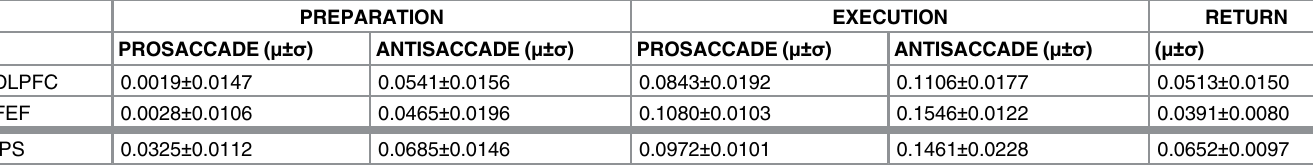
Table 3. Mean and standard error of normalised signal change for each saccade event